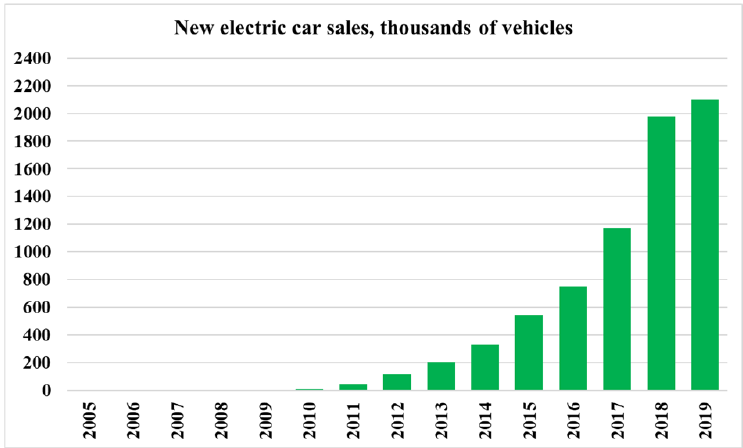
Figure 12. New electric car sales, thousands of vehicles [19] (p. 248). The use of environmentally friendly renewable solar energy to provide a million homes with energy can reduce carbon dioxide emissions by 4.3 million tons per year [20], by more than 1350 kg in just one household. The use of electricity generated by solar panels allows less electricity consumption from the general network, and reduces costs. Having sufficient capacity in the home system allows to sell the electricity generated by the energy of the sun. Solar panels provide energy independence. There will always be